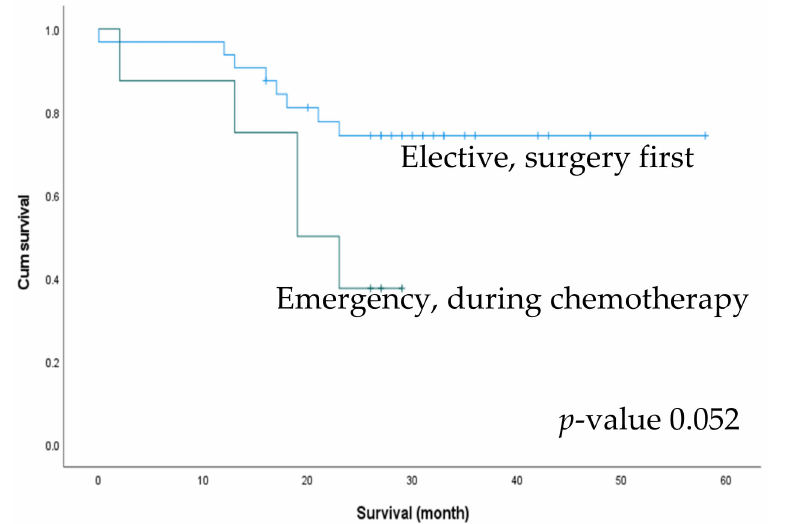
Figure 4. Comparison of 2-year survival outcomes between surgery first patients in the elective group and patients with an emergent event during chemotherapy.